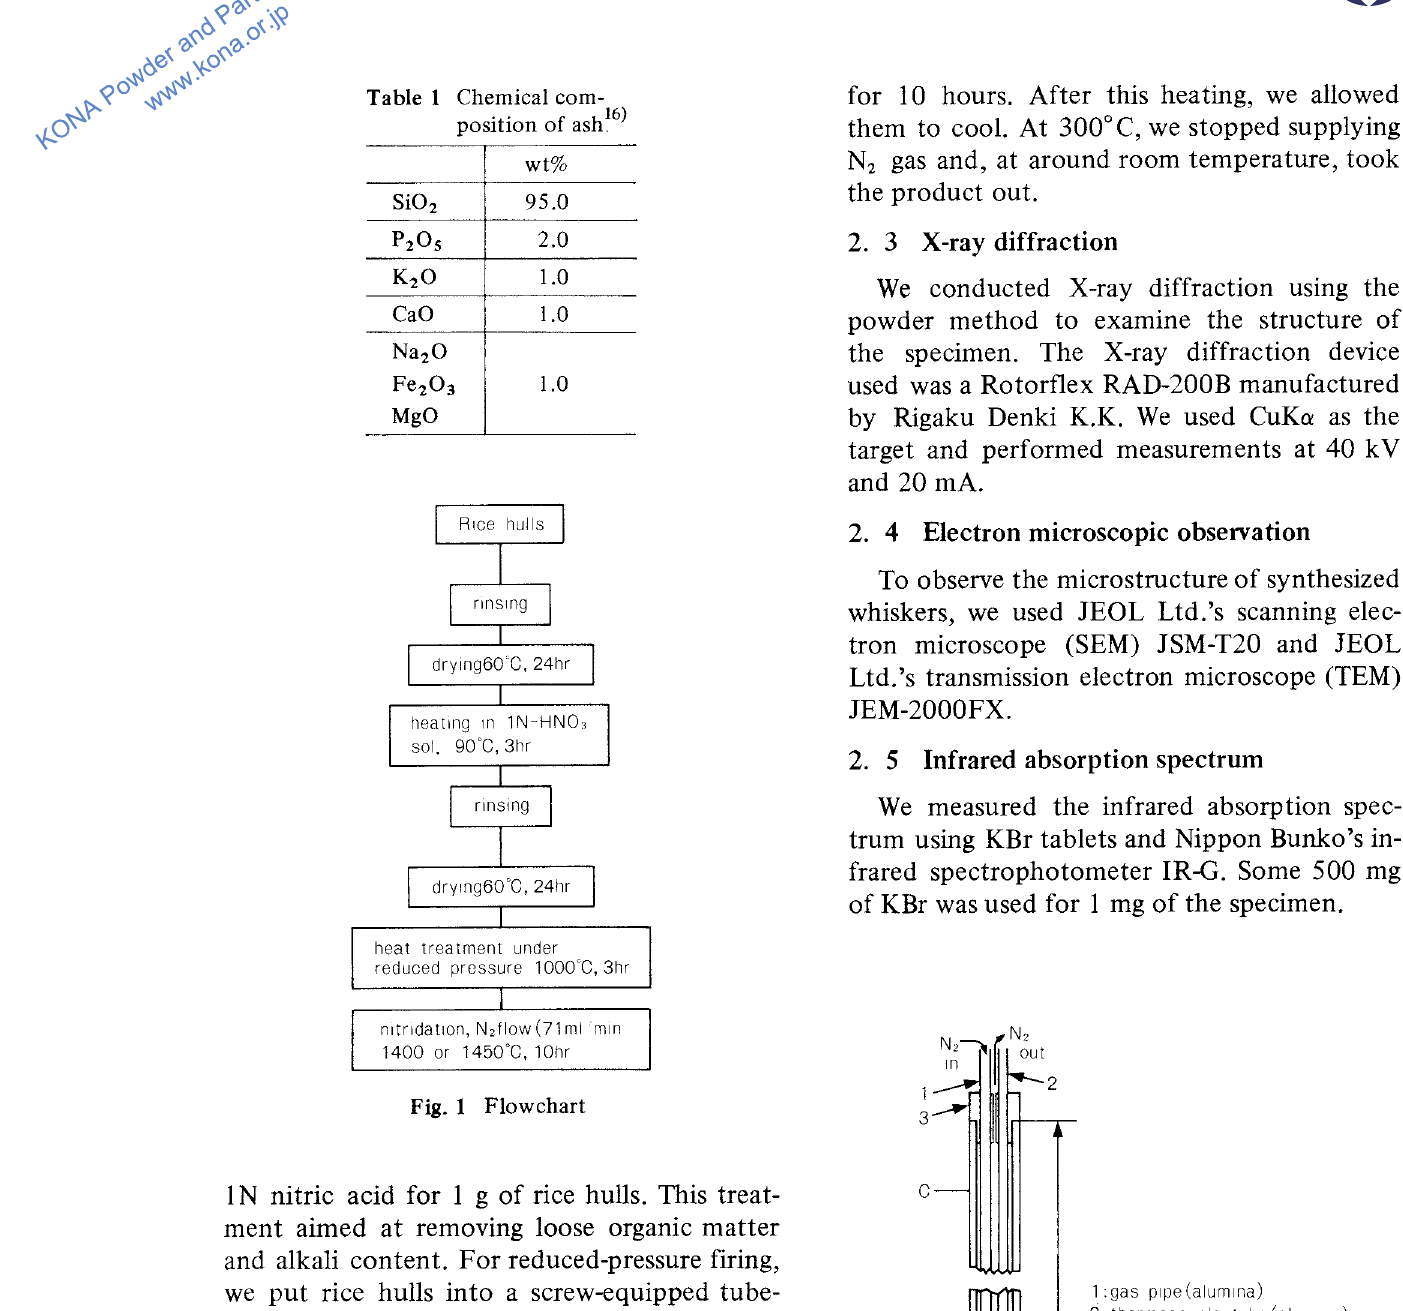
Table 1 Chemical com- . .